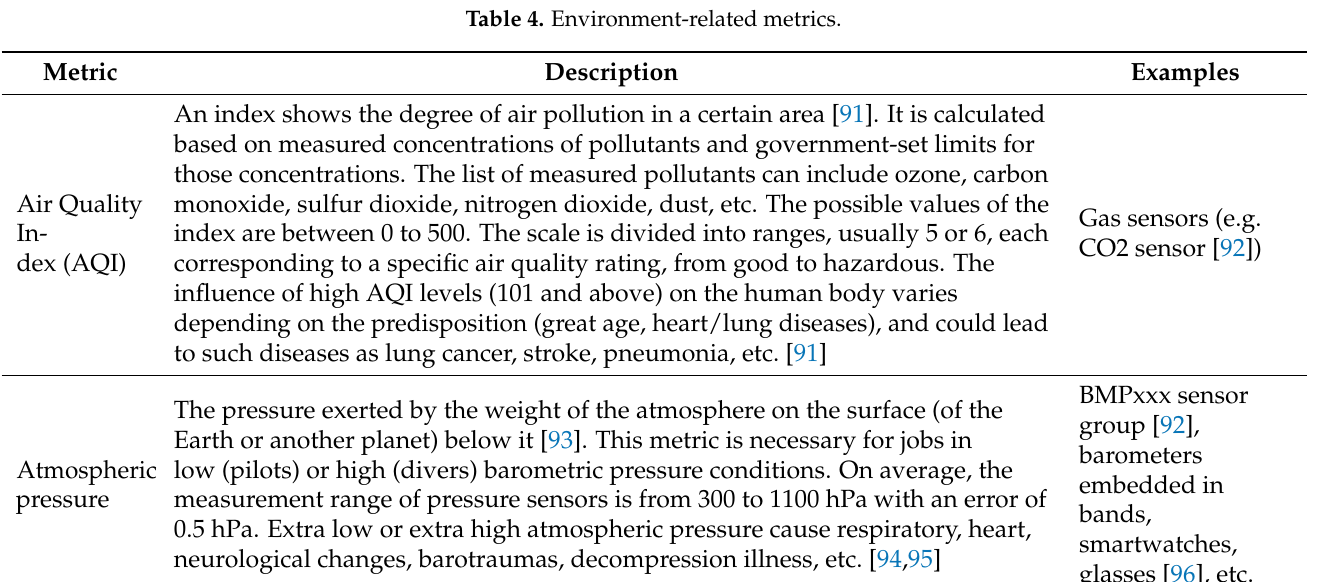
Table 4. Environment-related